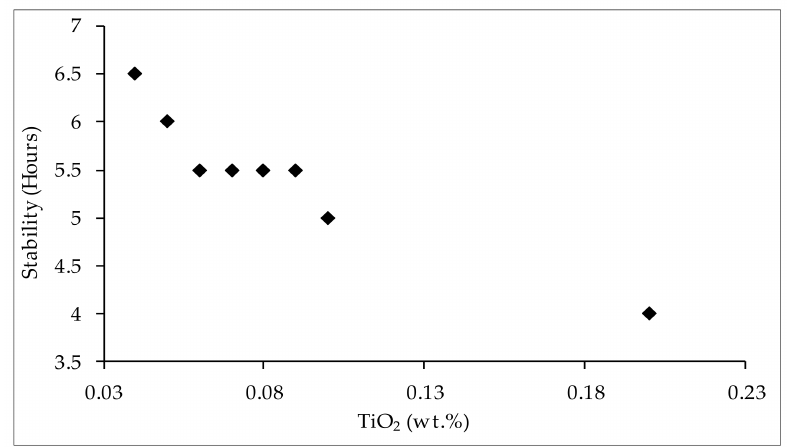
Figure 10. Leena and Srinivasan’s experimental results.